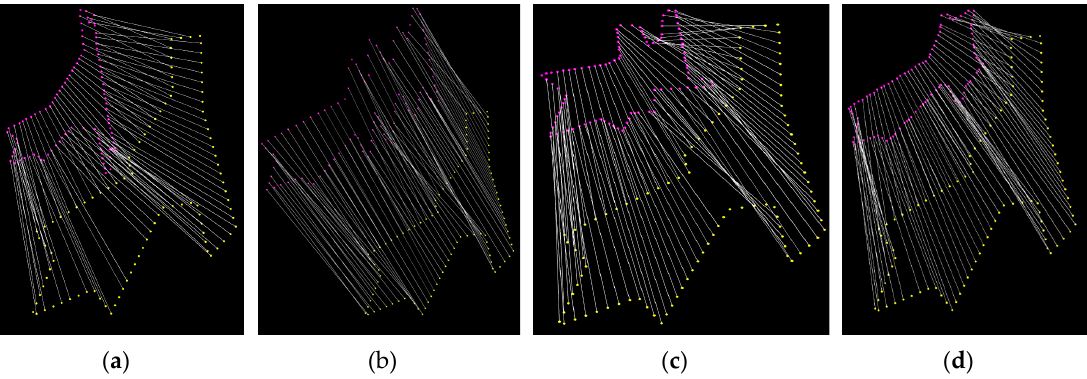
Figure 7. IDSC shape matching results. The red points are subsampled from the projected models with different types and the yellow points are subsamples from the same pylon in the image. ( a ) The same type of pylon is matched; ( b – d ) different types of pylon are